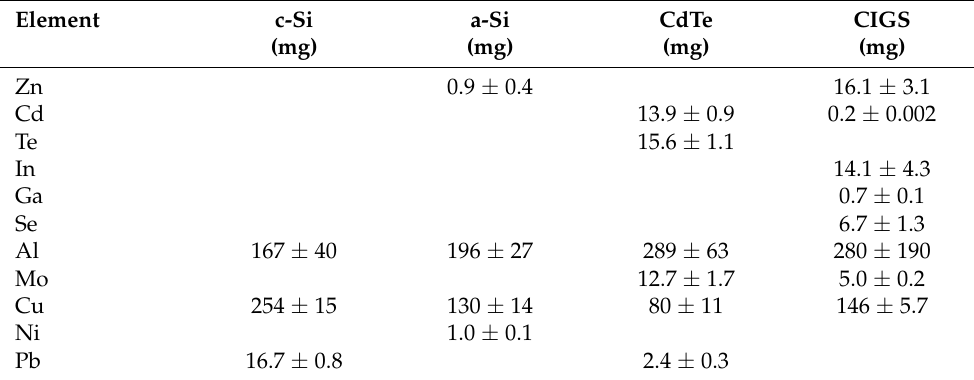
Table 2. Elemental mass M total in the 5 × 5 cm 2 module pieces for crystalline silicon (c-Si), amorphous silicon (a-Si), cadmium telluride (CdTe), and copper indium gallium diselenide (CIGS). The data represent mean values and the standard deviation from three